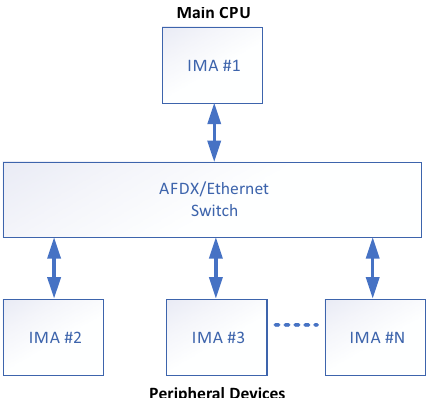
Figure 11. Topology of the classical “copper” onboard network.